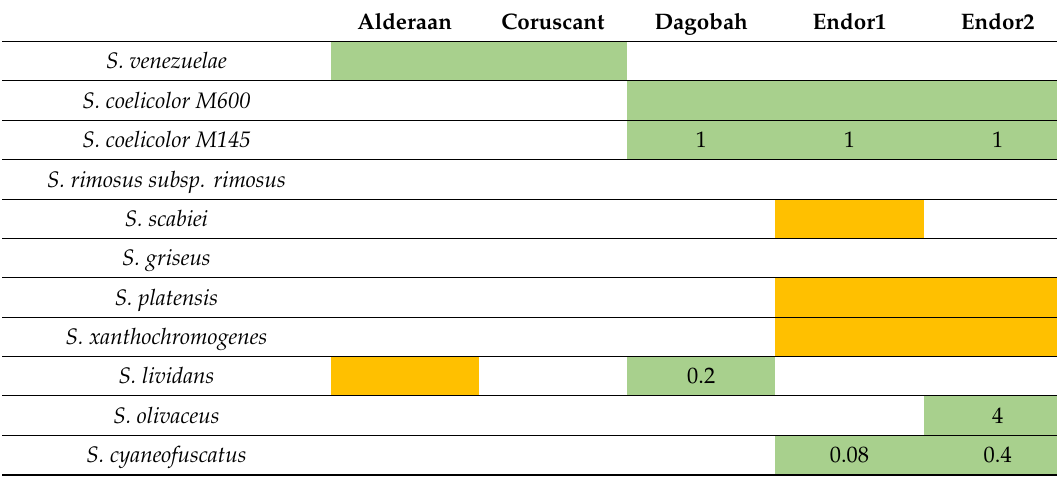
Table 1. The host range of the five phages was assessed by spotting serial dilutions of these phages on lawns of di ff erent Streptomyces species propagated on GYM medium. The outcome of the spot assays is reported as follows: plaque formation (green), clearance of the bacterial lawn without visible plaques (yellow), no plaque or lysis visible (no color). The e ffi ciency of plating (EOP) of a phage on a given strain relative to the host used for isolation is indicated, when plaques are countable. Alderaan Coruscant